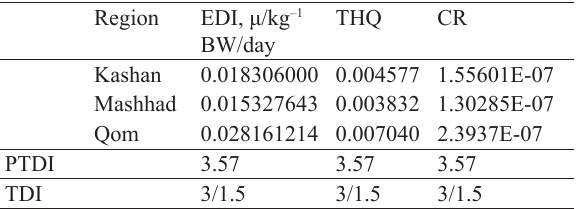
Table 3 EDI, THQ, and CR of lead for national consumers of eggs in different regions